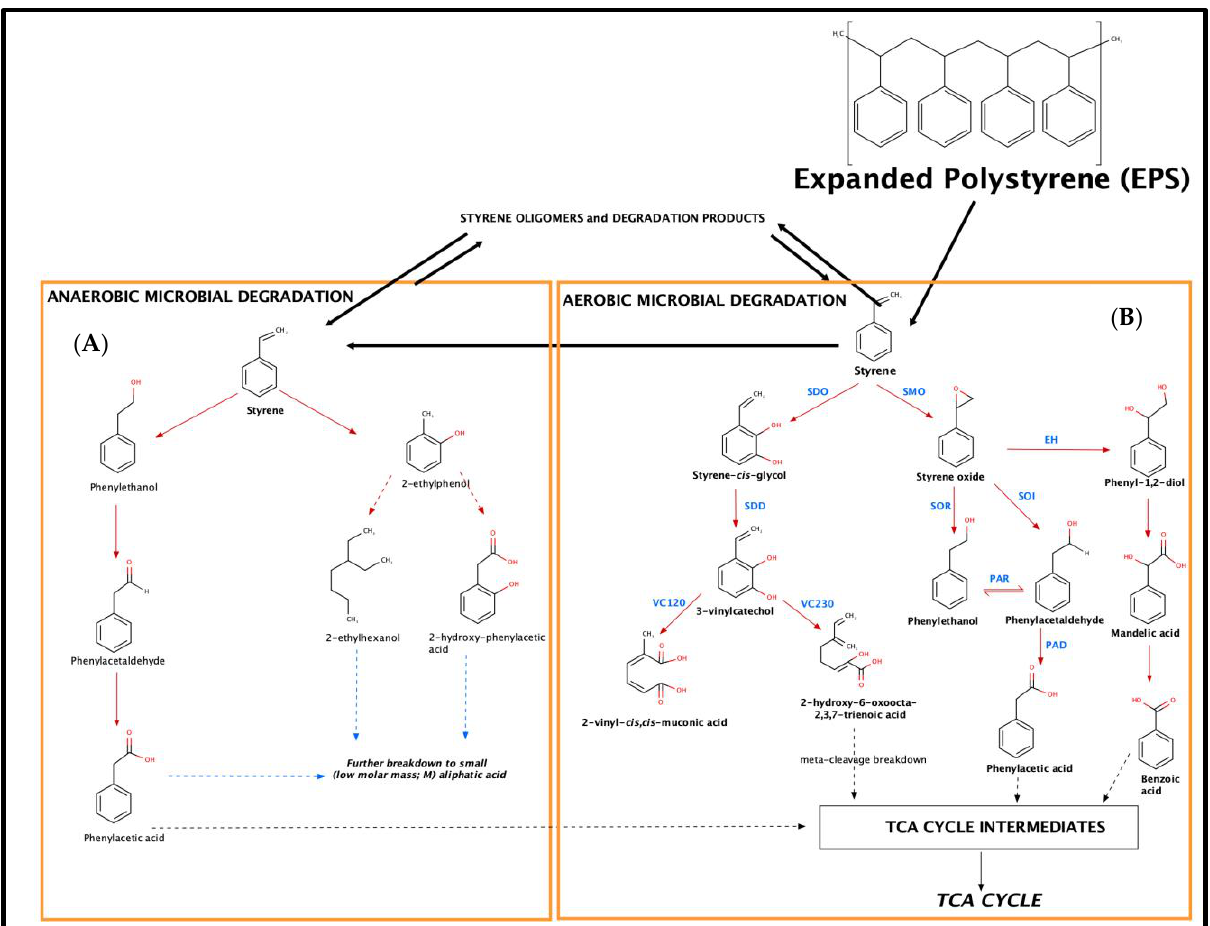
Figure 3. Identified degradation products and metabolic pathways for: ( A ) anaerobic degradation and ( B ) aerobic degra- dation (abbreviations: SMO — styrene monoxygenase; SOI — styrene oxide isomerase; SDO — styrene-2,3-dioxyxegenase; VC12O — vinylcatechol 1,2-dioxygenase; VC230 — vinylcatechol 2,3-dioxygenase; SOI — styrene oxide isomerase; PAD — phenylacetaldehyde dehydrogenase; SOR — styrene oxide reductase; PAD — phenylacetaldehyde dehydrogenase) (adapted from [21,23,29]).